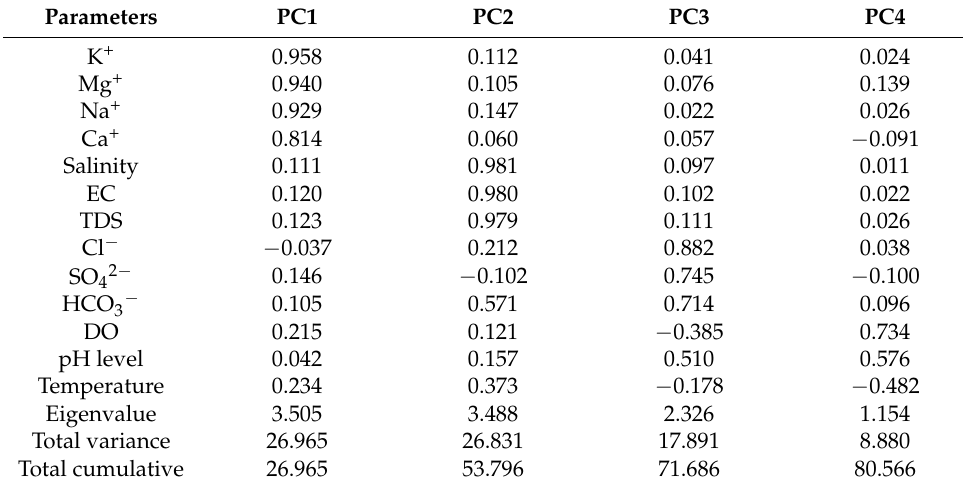
Table 7. Principal component loading of the measured